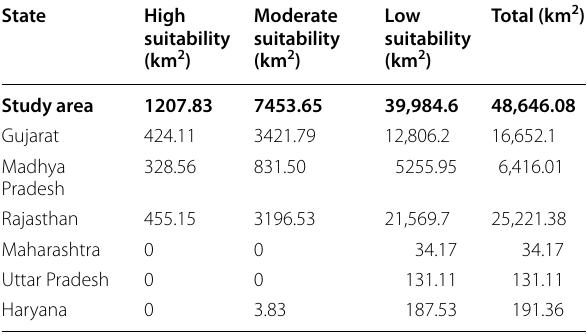
Table 1 Details on gradient of available suitable habitats for caracals coming under the political states in